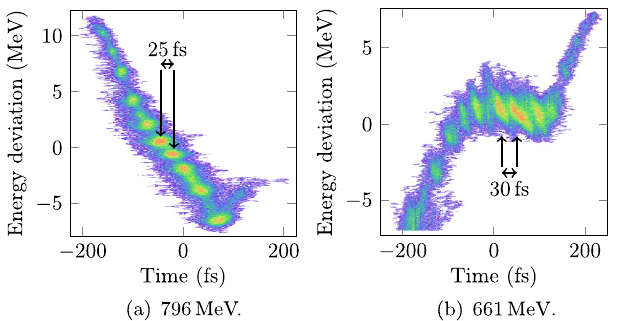
FIG. 3. Longitudinal phase space measurements upstream of the undulators at ES-CCD for two different compression settings and mean energies: (a) 796 MeV and (b) 661 MeV. The density modulations indicate microbunching in the time-domain with periods of (cid:3) 25 fs and 30 fs,